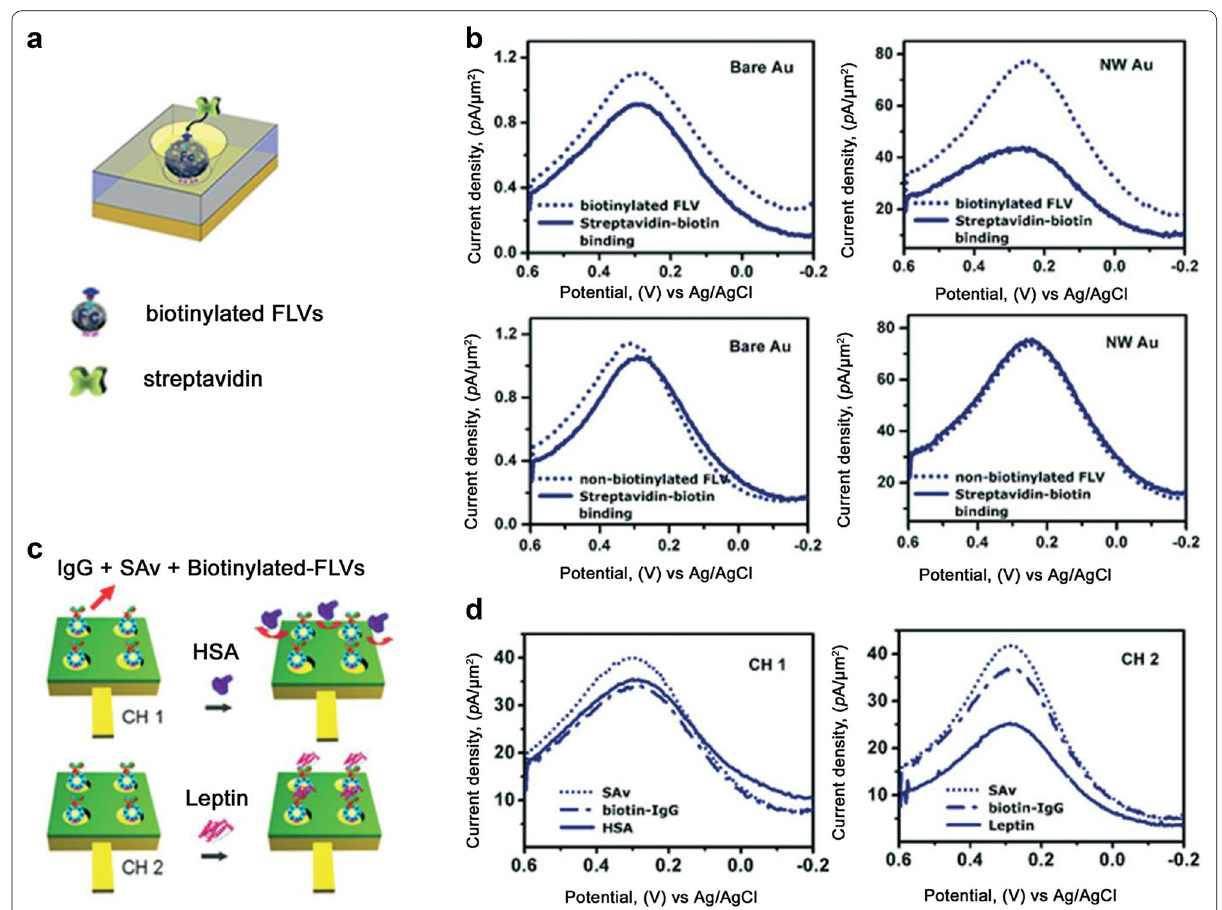
Fig. 14 a A schematic illustration of the binding event between streptavidin and the captured biotinylated FLVs on NW electrode. b SWV measure- ments. c A detection scheme of leptin. d SWV measurements of current density after addition of the biotinlylated anti-leptin